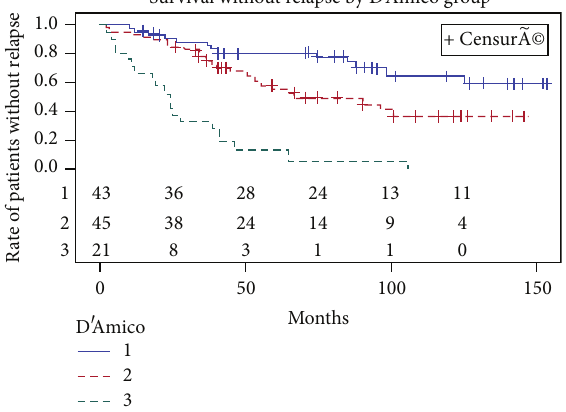
Figure 2: Kaplan-Meier curves of biochemical recurrence free survival using Phoenix definition (nadir + 2 ng/mL) according to D’Amico risk